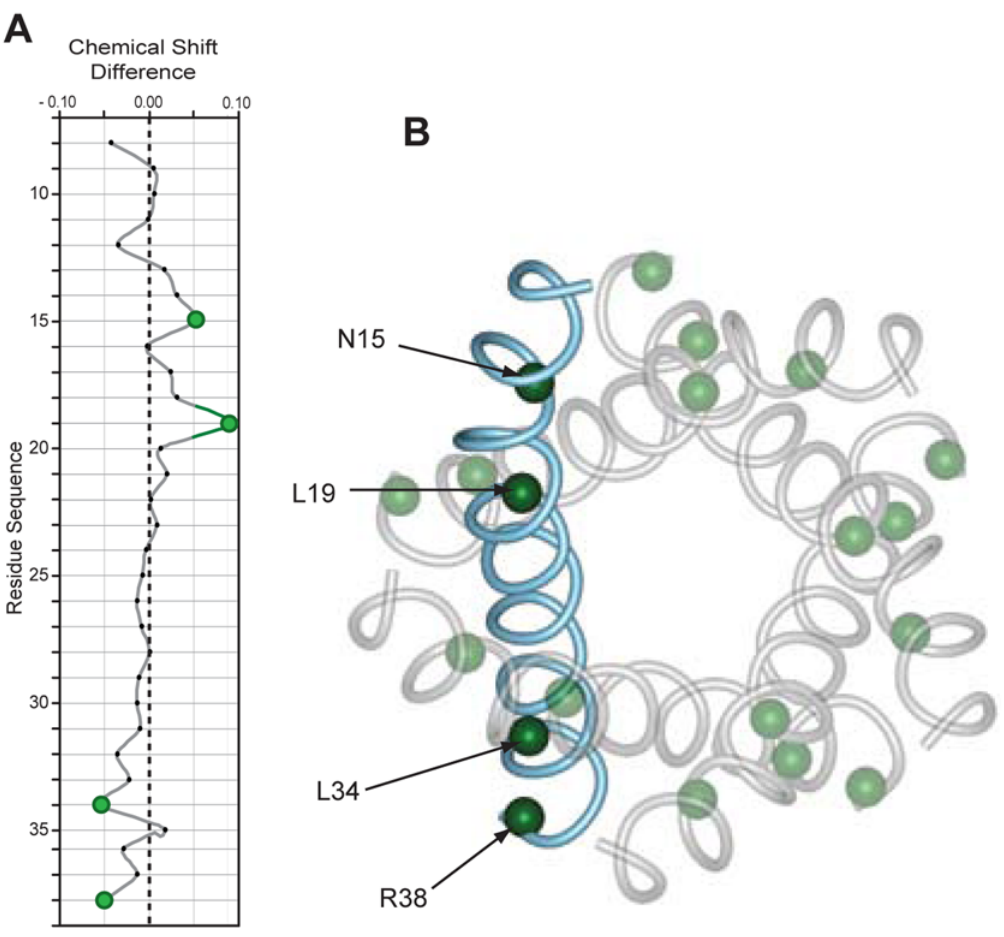
Figure 5. Chemical shift perturbation in ETM induced by HMA. (A) Difference in the 1 H N chemical shifts (ETM minus ETM HMA ) after addition of HMA at the molar ratio described in Methods. Amides exhibiting deviations of chemical shifts of more than 0.05 ppm are highlighted in green. (B) Top view of the ETM pentameric model showing these amides as small spheres.